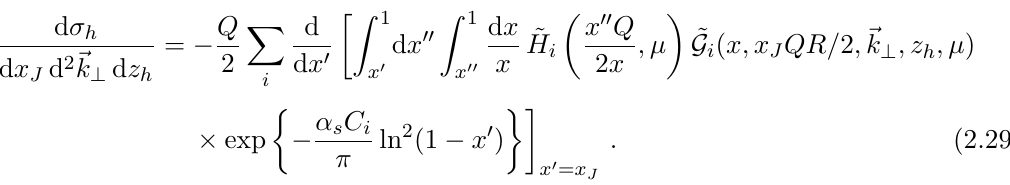
Figure 8 . Requiring x (cid:21) x c prohibits emissions in the (blue) shaded region of phase-space, in terms of the momentum fraction z and transverse momentum ^ q in eq. (2.27) of the emission. ? Sudakov factor in eq. (2.28) to the x J